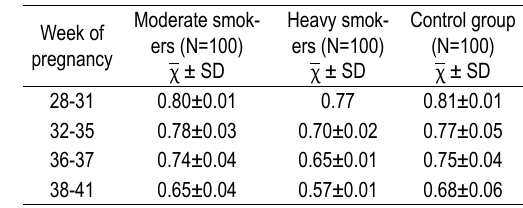
Table 2. resistance index in fetal aorta Table 3. resistance index in the middle cerebral artery